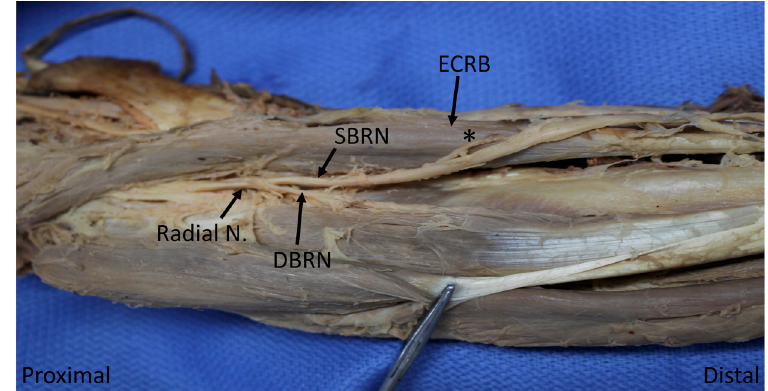
Figure 2. Nerve to extensor carpi radialis brevis (*) arising from the superficial branch of the radial nerve. ECRB: extensor carpi radialis brevis; SBRN: superficial branch of radial nerve; DBRN: deep branch of radial nerve.